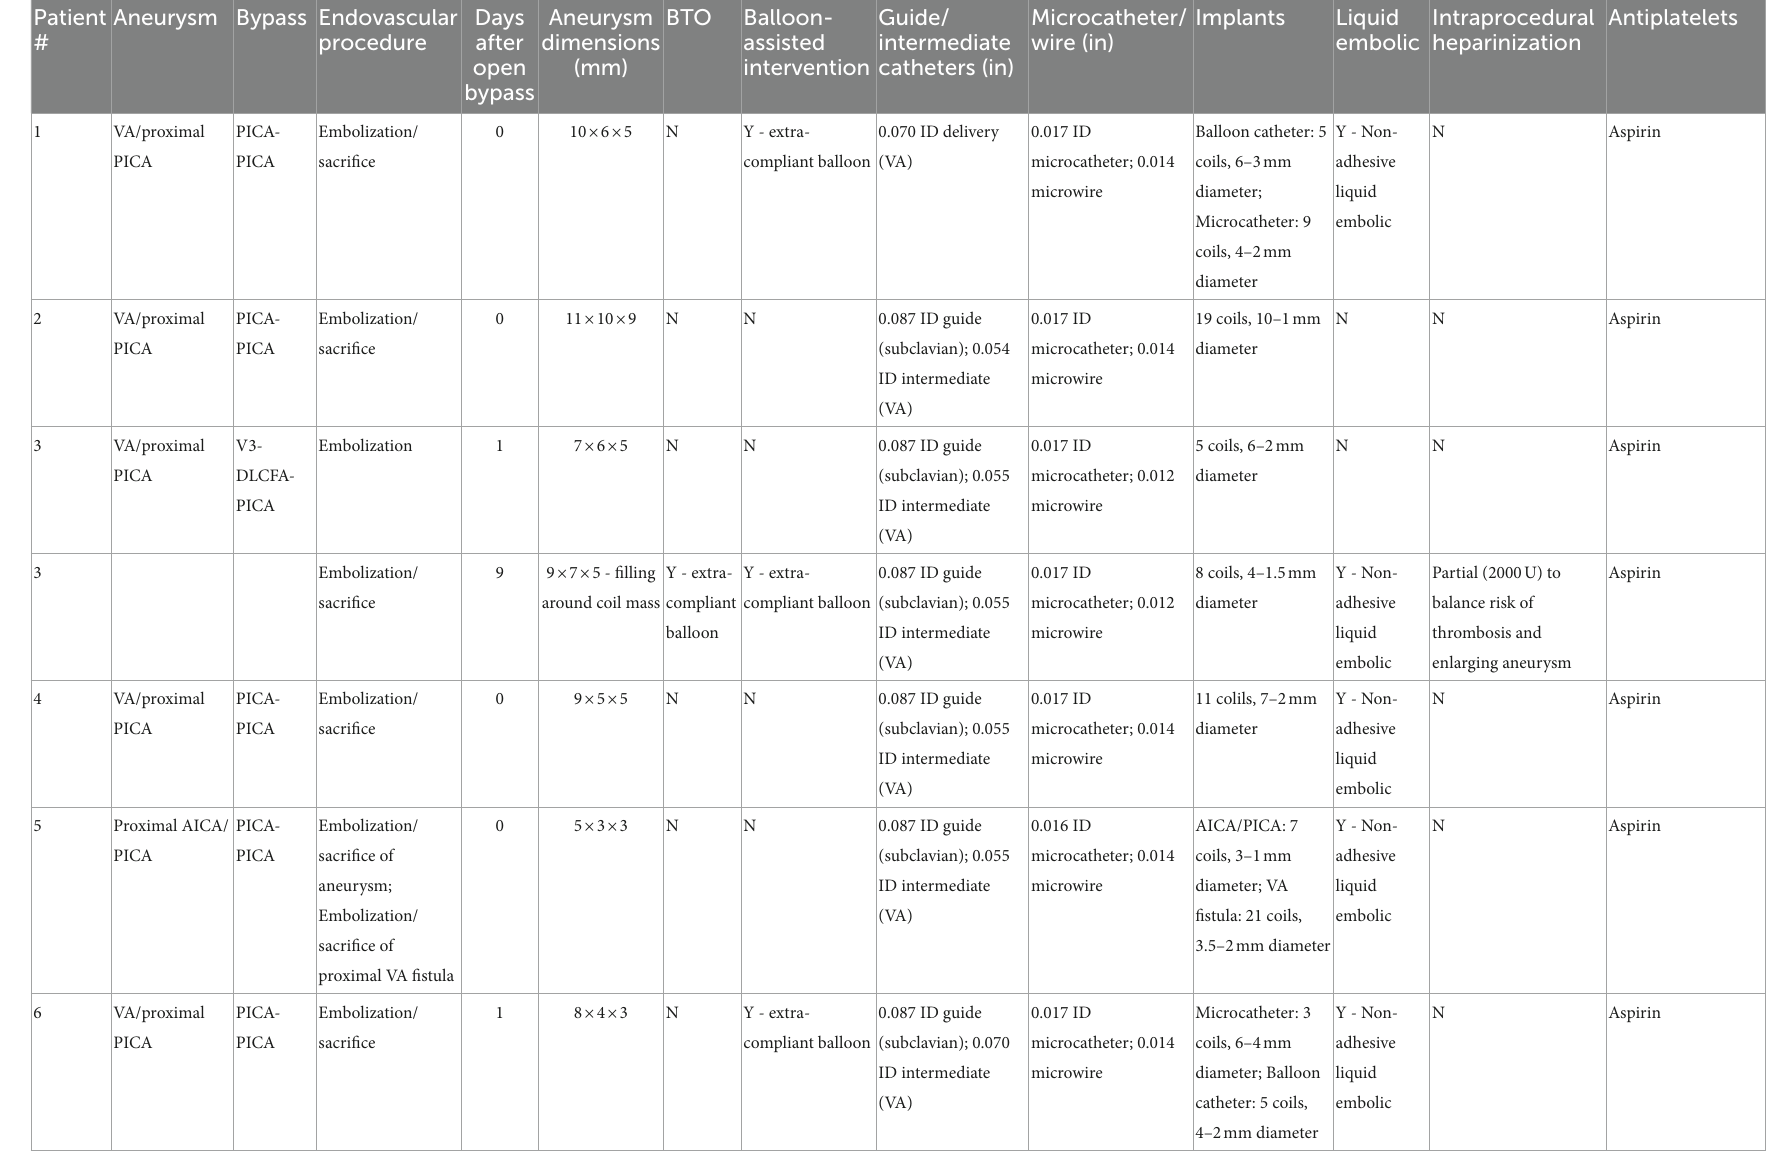
TABLE 2 Summary of treatment